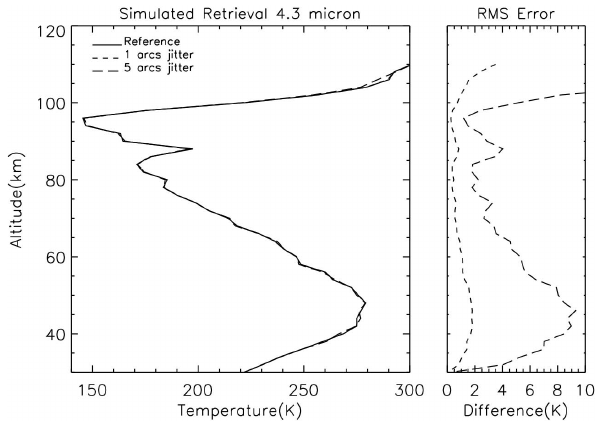
Fig. 16. The iteration sequence for a temperature profile with sig- nificant vertical structure. Right-hand panel shows the difference from truth of retrieved profile after 10 iterations.